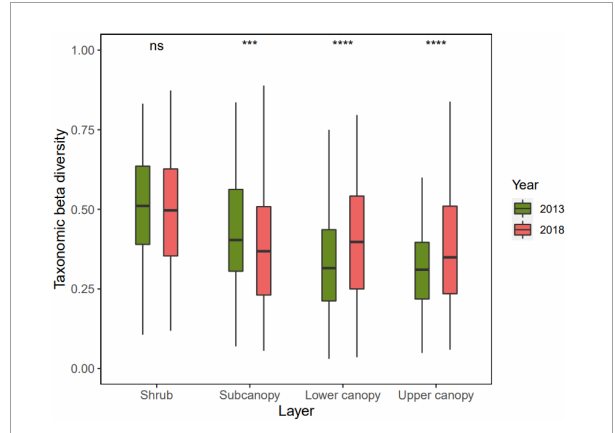
FIGURE3 Changes of taxonomic beta diversity in four vertical stratification in the Dongbaishan forest between 2013 and 2018. ns p > 0.05, * p ≤ 0.05, ** p ≤ 0.01, *** p ≤ 0.001, **** p ≤ 0.0001.